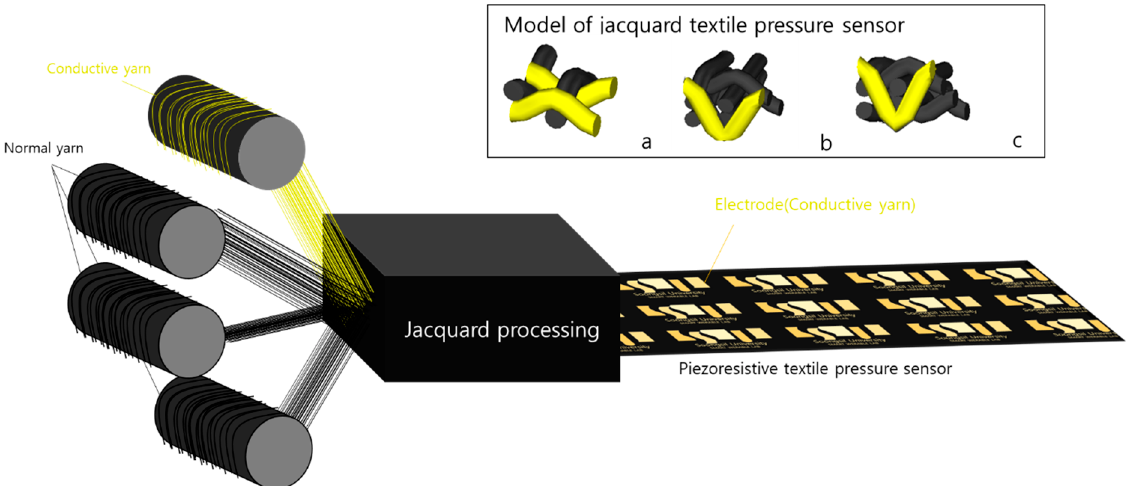
Figure 1. Manufacturing of 3 structure types of piezoresistive textile pressure sensors using Jacquard processing: ( a ) single layer, ( b ) double layer, and ( c ) quadruple layer.